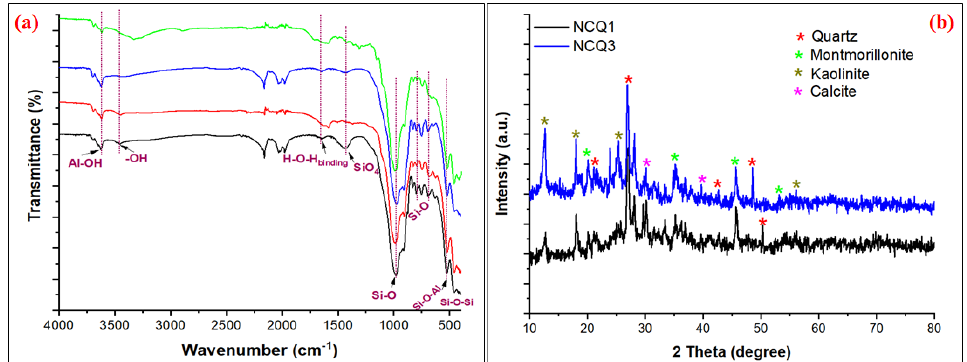
Figure 2. ( a ) FT-IR spectra ( b ) XRD pattern of NCQ1 and NCQ3 adsorbents.